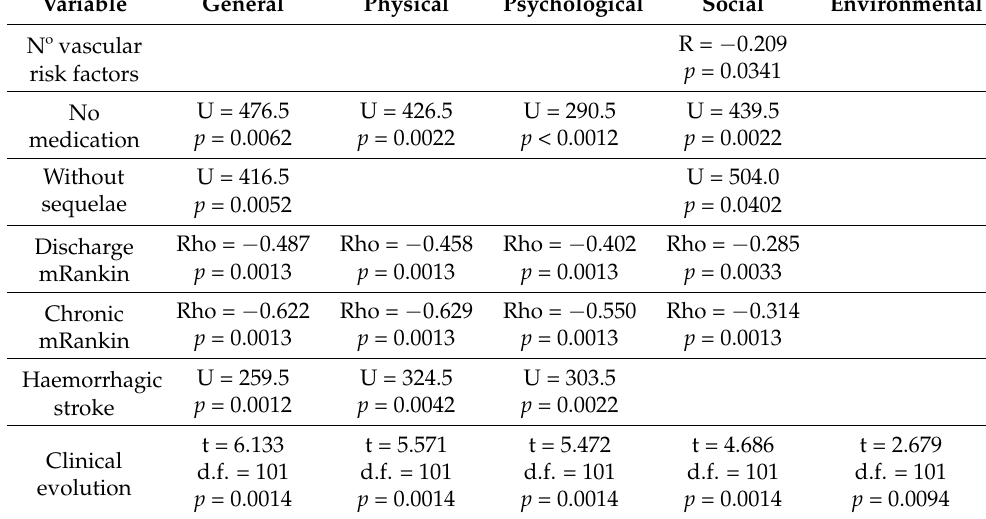
Table 4. Association between HRQoL domains of the and clinical variables ( n = 102).